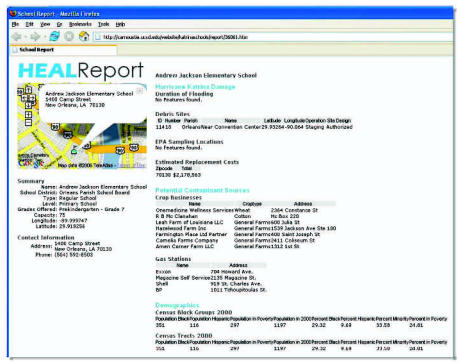
NIEHS Portal HEAL application (NIEHS 2006b).